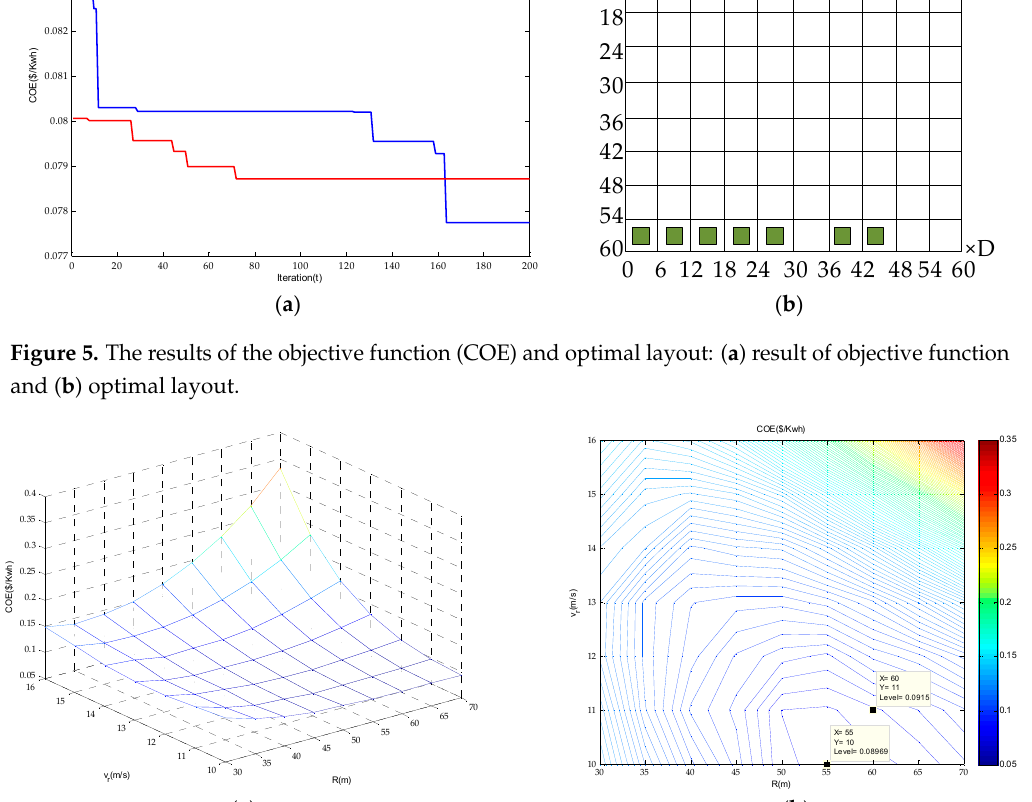
Figure 6. The relationship between the speed, rotor radius and COE at XIPP, China: ( a ) 3D graphic and